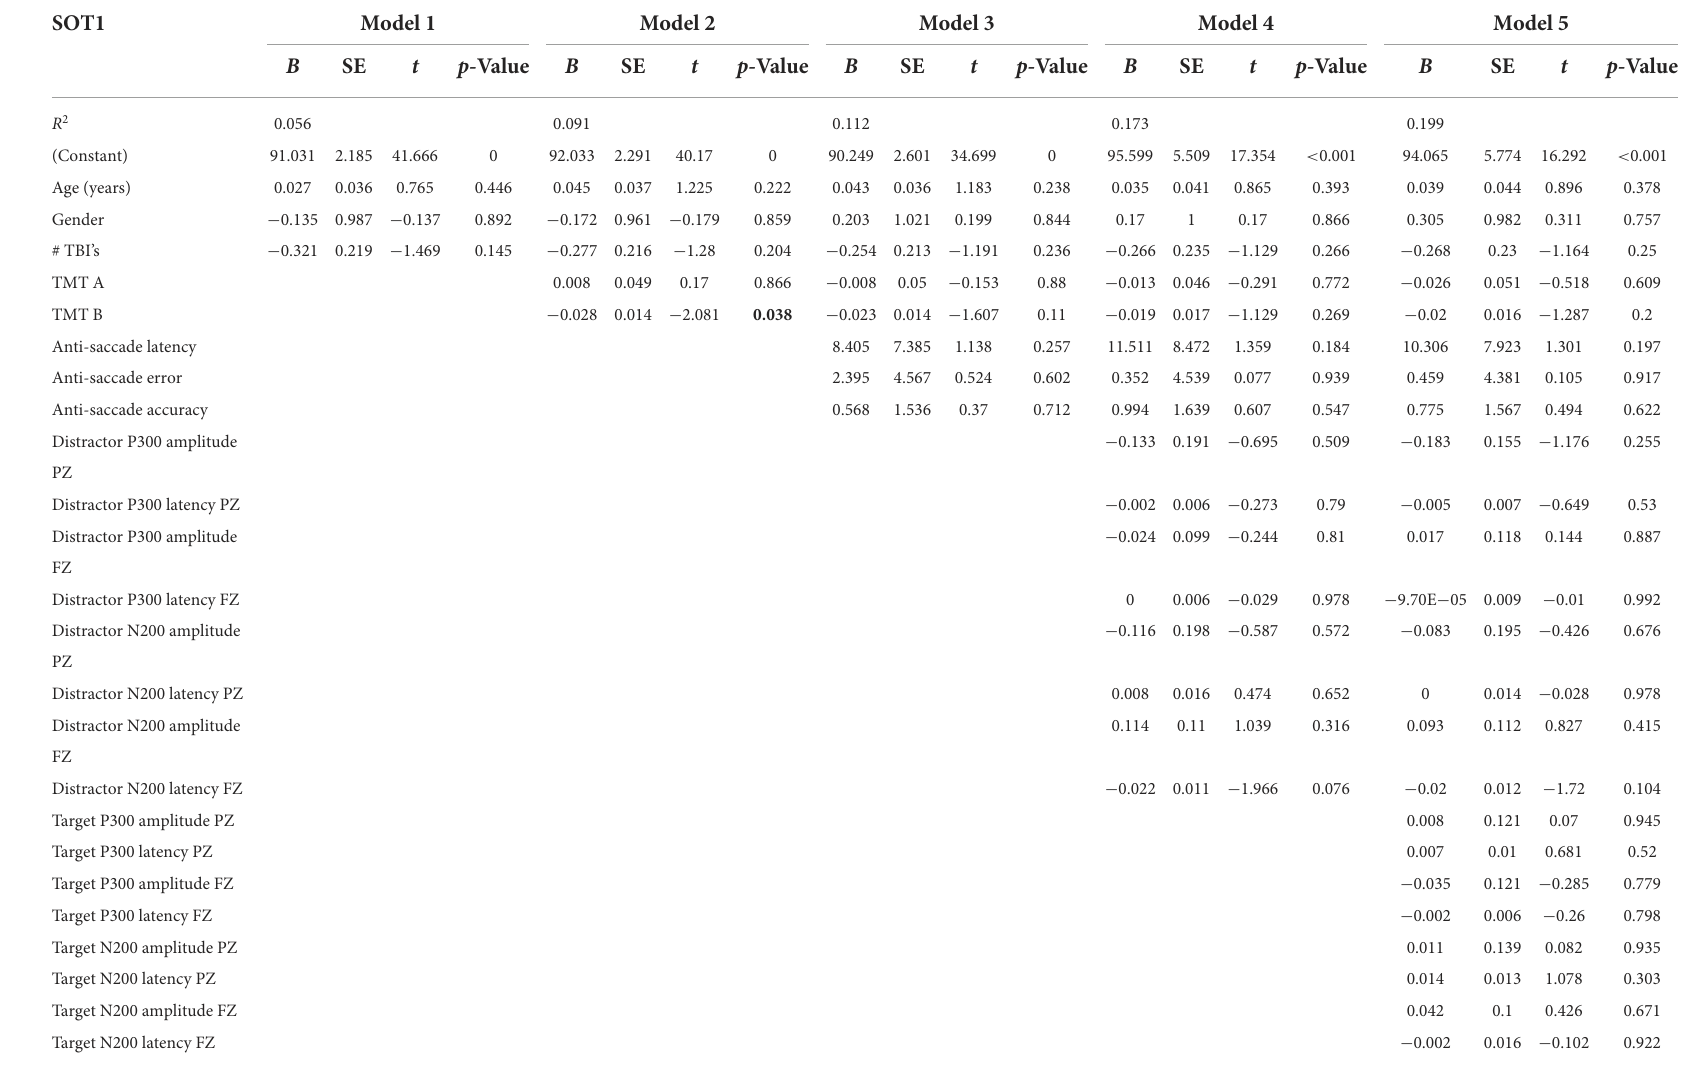
TABLE 3 Results from the hierarchical regression for SOT1, standing